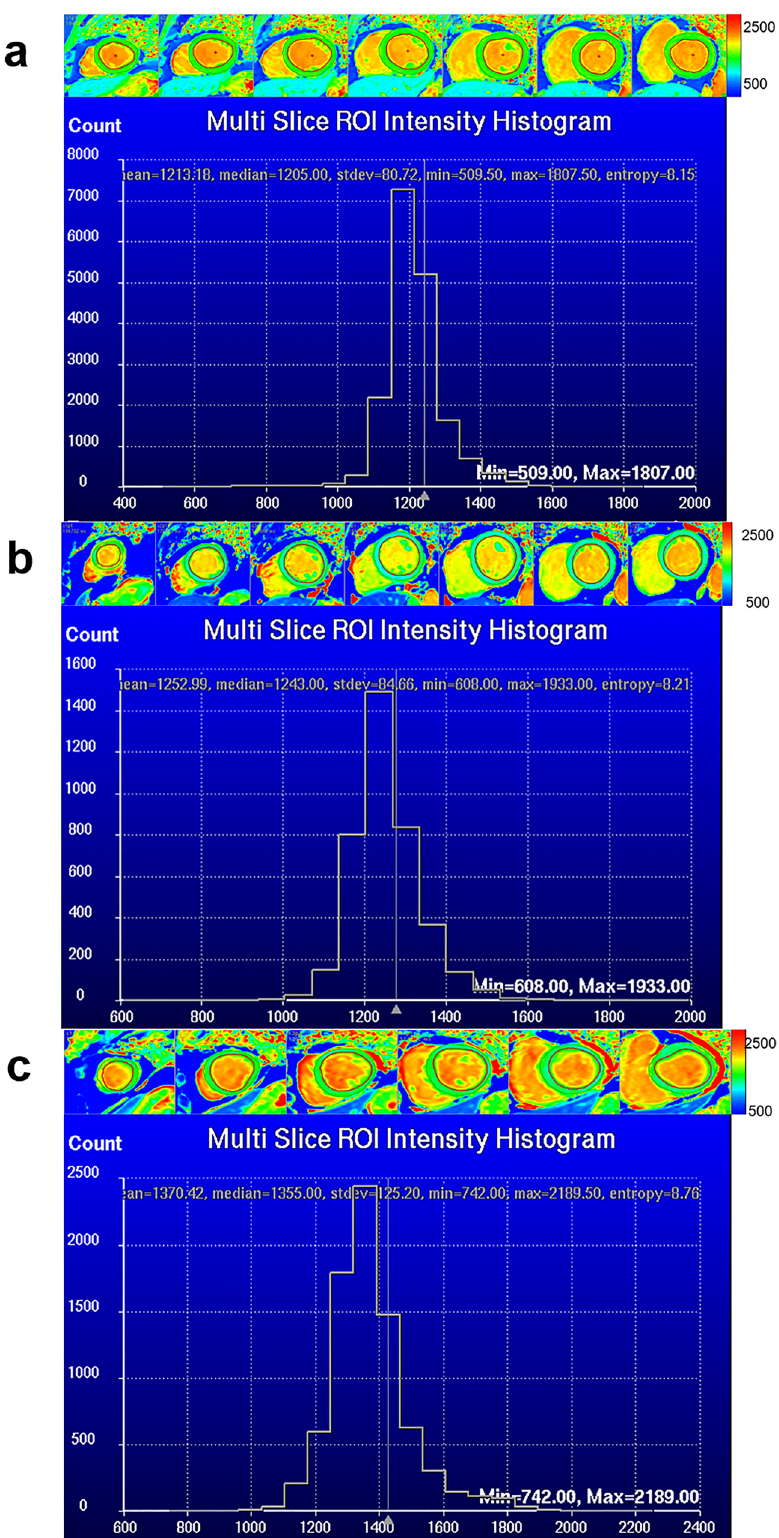
Figure 2. All slices of native T1mapping images and histograms of controls ( a ), IIM-C-( b ) and IIM-C + ( c )